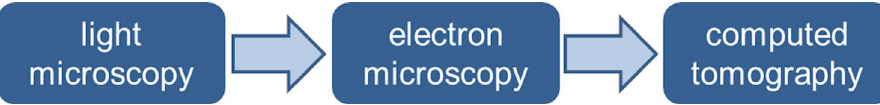
Figure 1. Flow diagram presenting the subsequent observations methods.